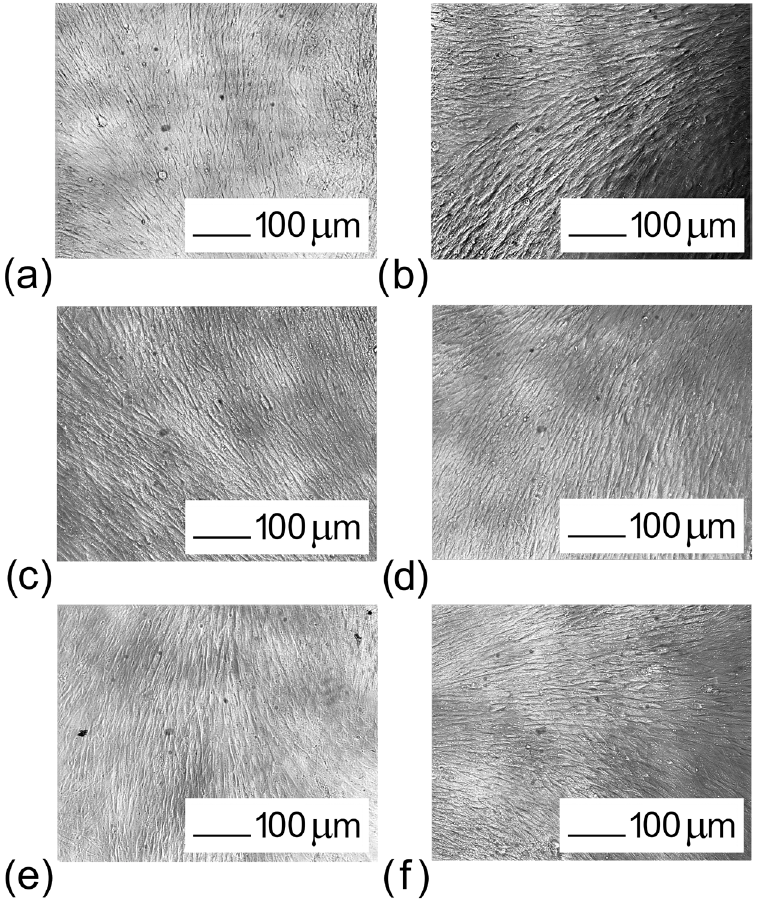
Figure 14. Micrographs of Man-1 cells cultured in the extraction media 3 days: ( a ) Control; ( b ) TiNi; ( c ) Ir’/TiNi; ( d ) Ir/Ir’/TiNi; ( e ) Au/TiNi; and ( f ) Ir/Au/TiNi.